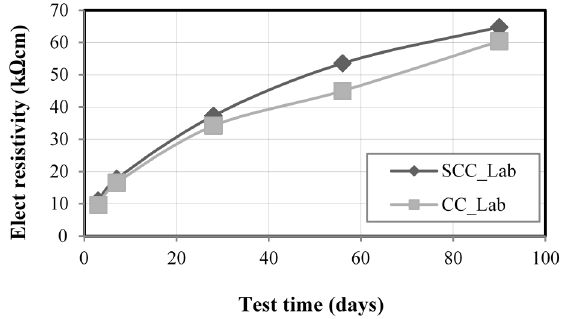
Figure 7. Electrical resistivity test